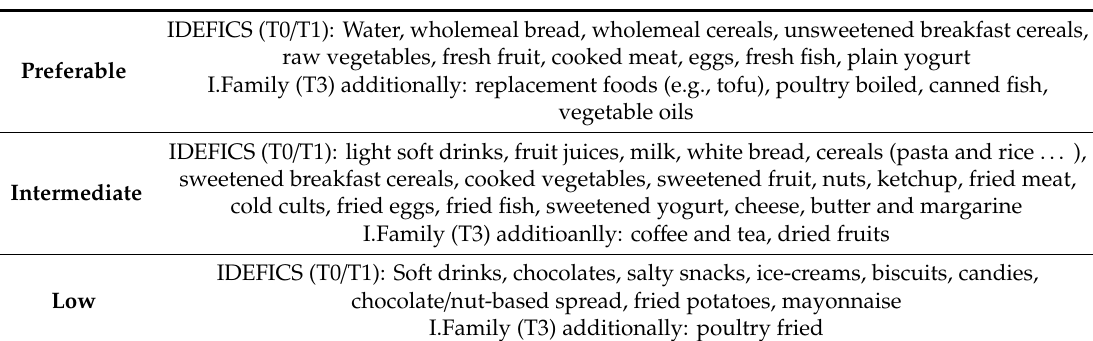
Table A1. Categorization of the food groups among ‘preferable consumption’, ‘intermediate consumption’, or ‘low consumtion’ groups n